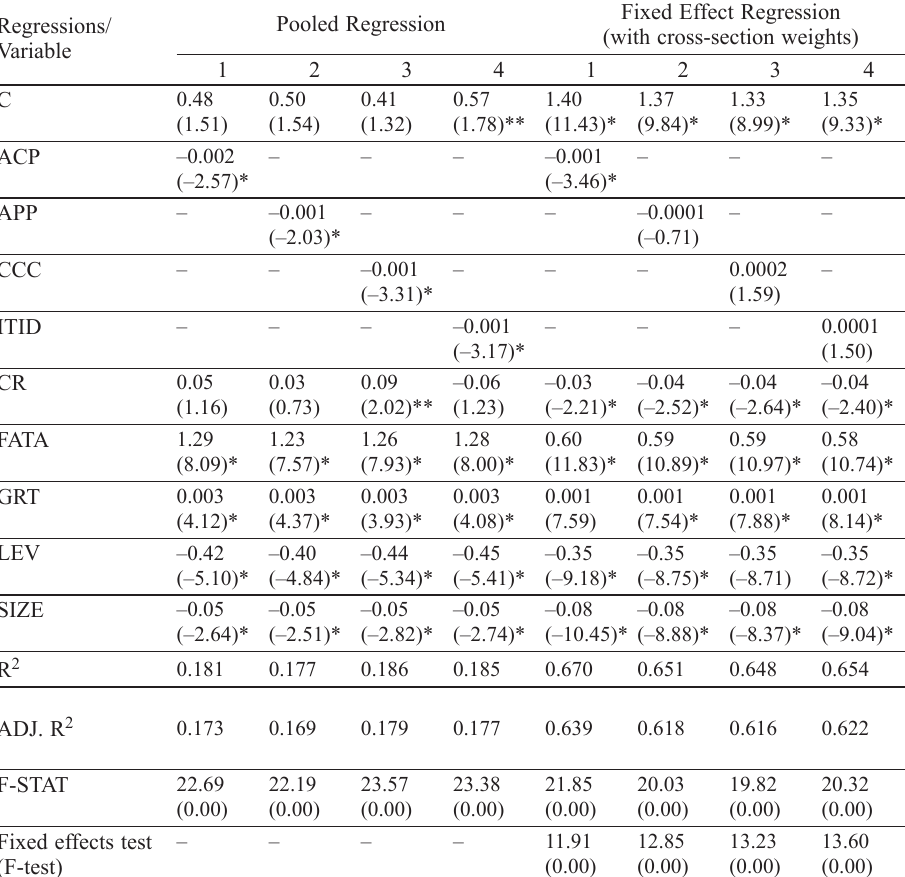
Table 3b. Regression of net operating profit on working capital variables Regressions/